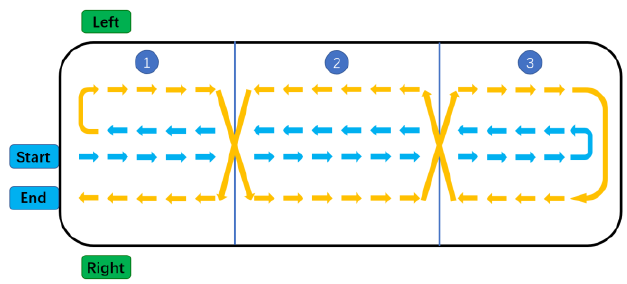
Figure 1. Walking route diagram of ship